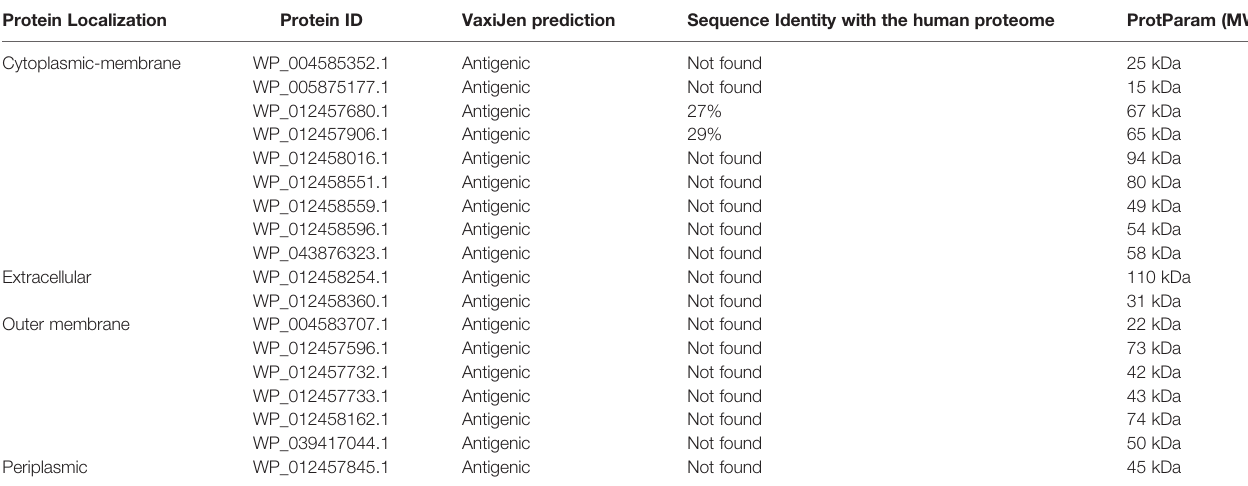
TABLE 1 | Selected proteins from P. gingivalis proteome for multiple epitope